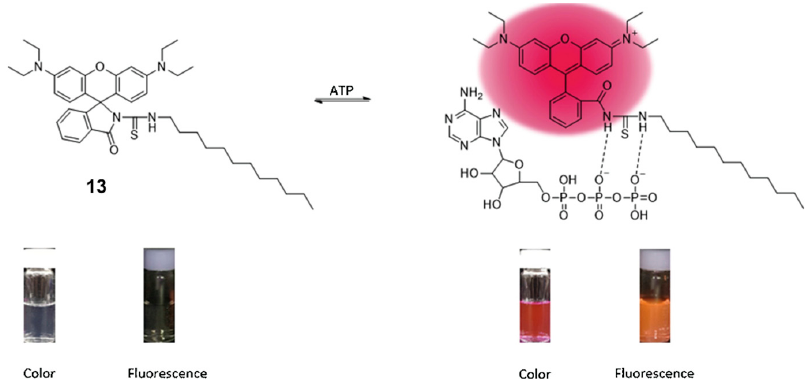
Figure 17. The colorimetric and fluorescent change of the mitochondria probe 13 with ATP by naked eye and its proposed binding mechanism. Adapted with permission from [234]. Molecules 2020 , 25 , 5964